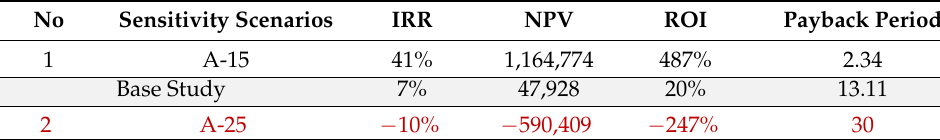
Table 8. Price adjustment scenarios A for the